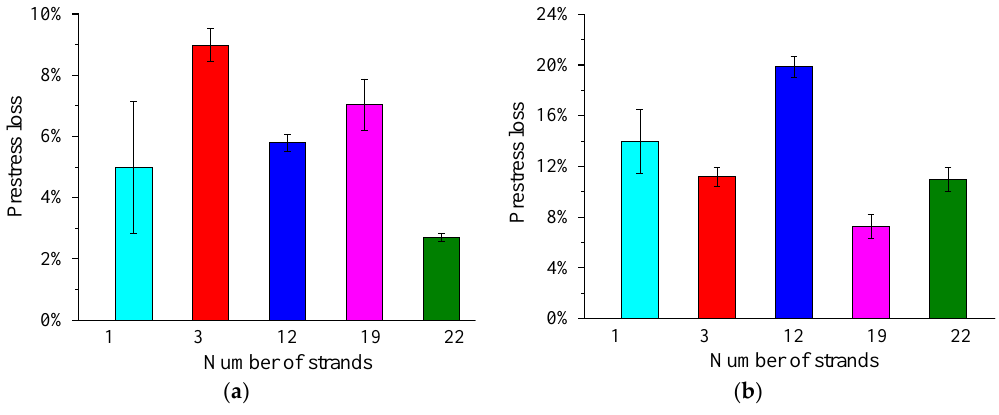
Figure 12. Average pre-stress losses: ( a ) straight duct; and ( b ) curve duct. Table 5. Measured pre-stress loss.